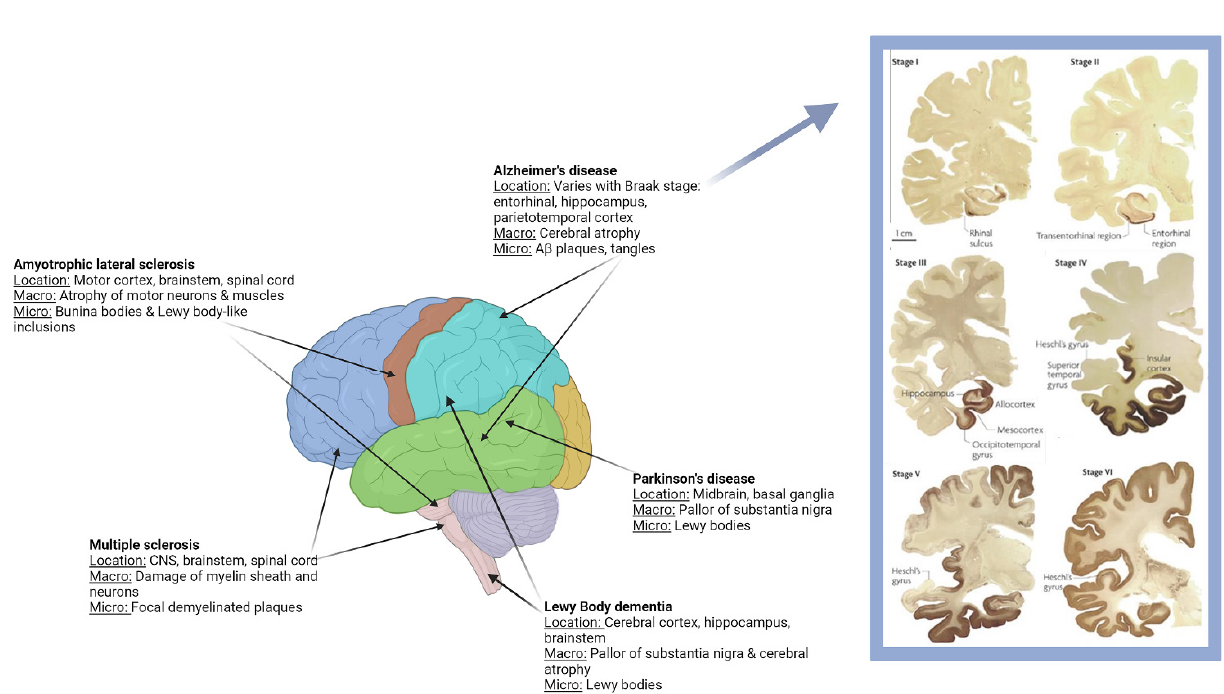
Figure 1. Association of specific diseases with affected regions of the brain. All figures/illustrations were created with BioRender.